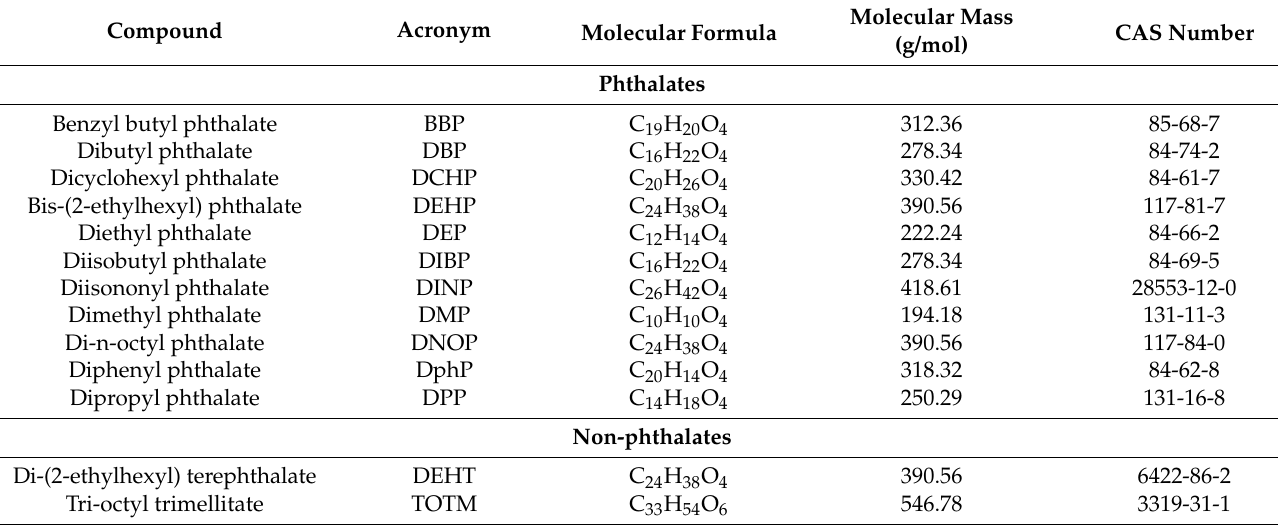
Table 1. Plasticizers investigated in this